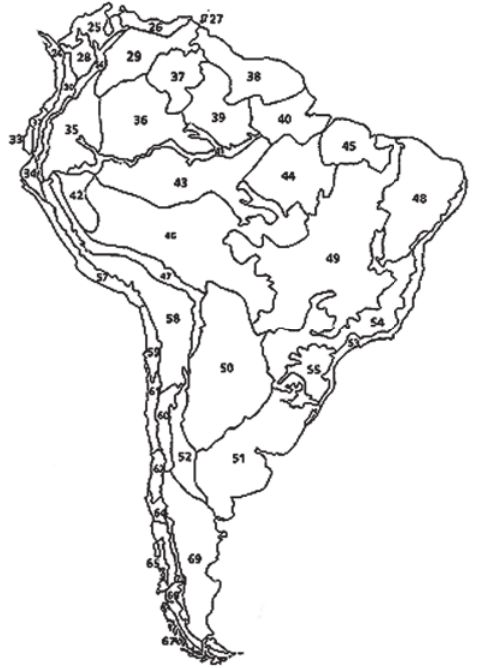
Fig. 25 - Map of biogeographic provinces (modifi ed from Morrone 2006).